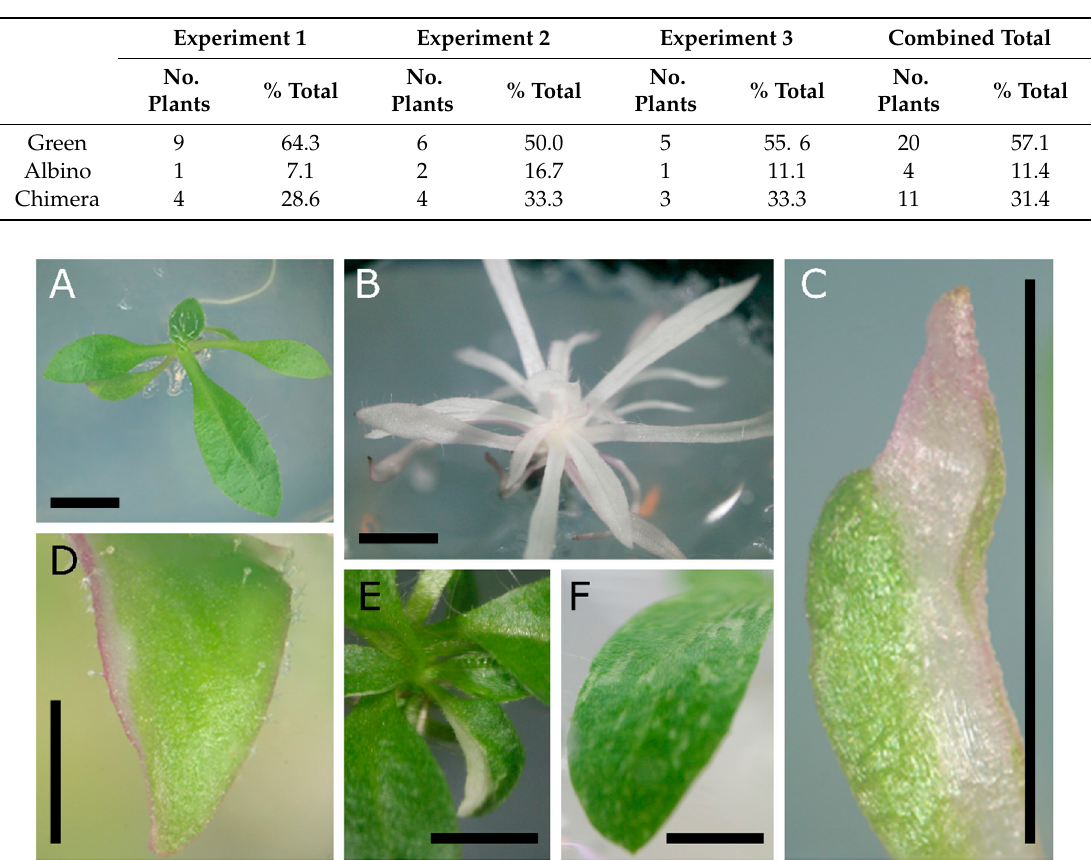
Table 1. Phenotypic frequency of recovered transformants after CRISPR / Cas9-mediated editing of the Hieracium PDS